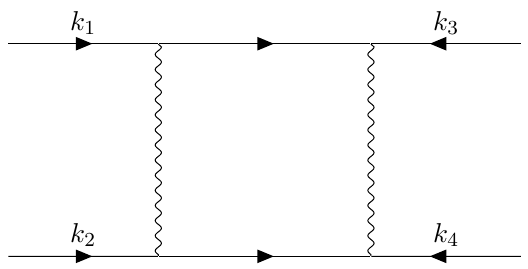
Figure 3 . Feynman diagram representation for one-loop scalar scattering with two graviton ex- changes. The solid lines represent scalar states and the wavy lines represent